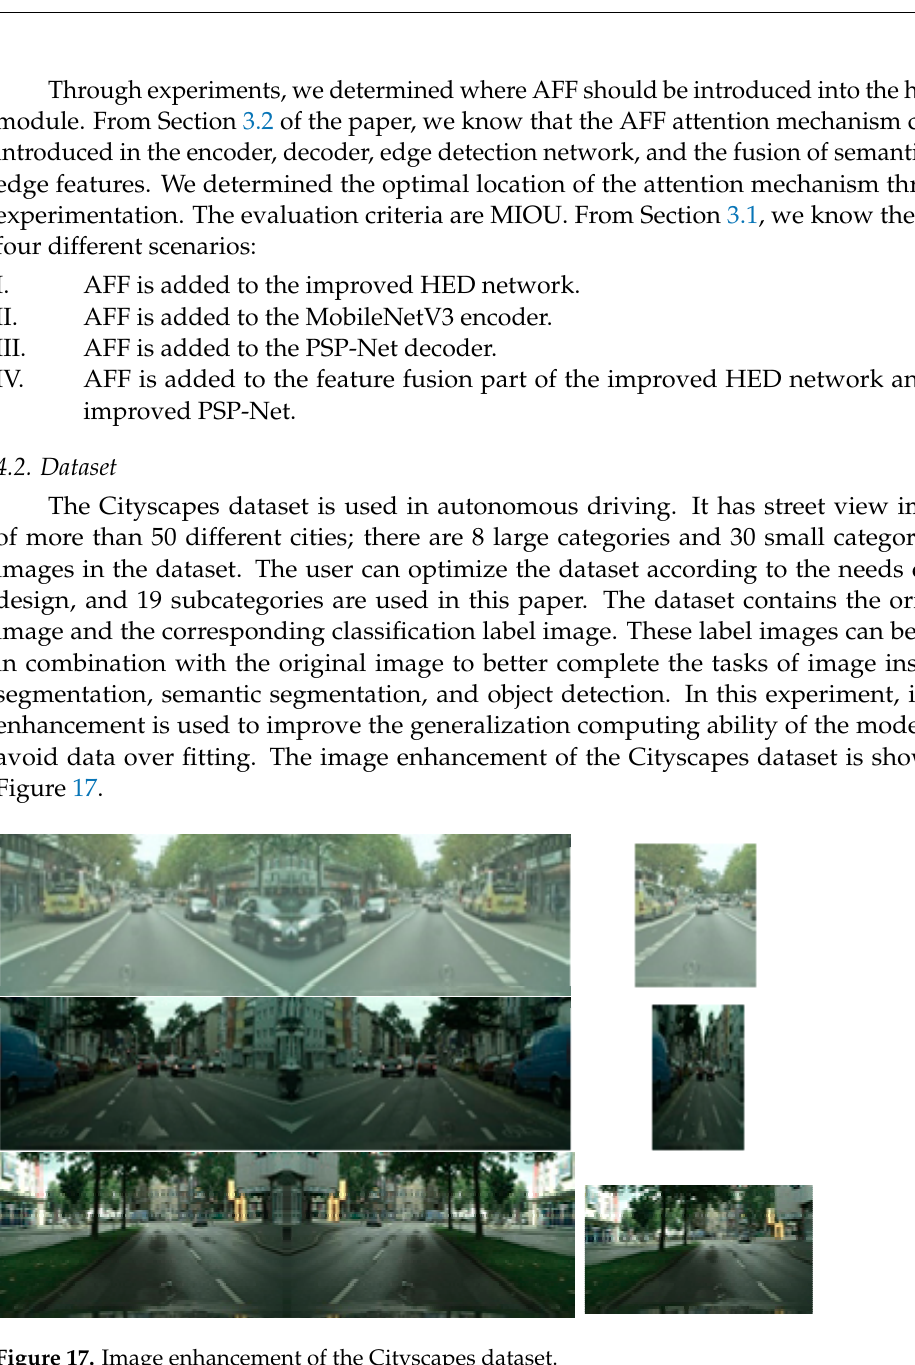
Table 5. Feature fusion MIOU comparison of different semantic segmentation networks on Cityscapes